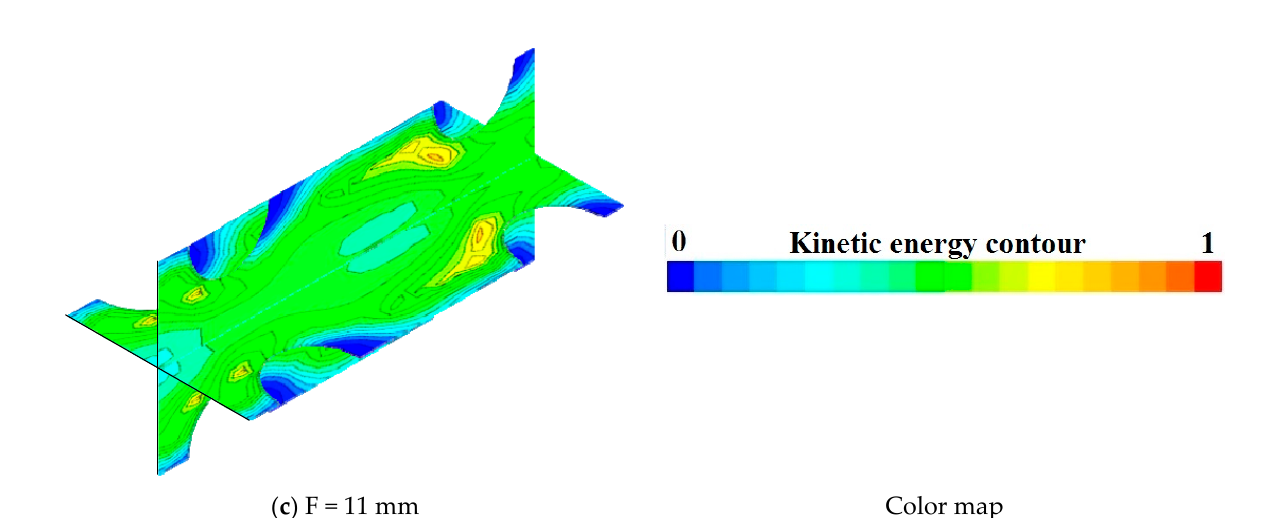
Figure 30. Kinetic energy contours for various configurations of Case F with different F parameters at Re = 15,000, and 𝜑 = 0.5%.